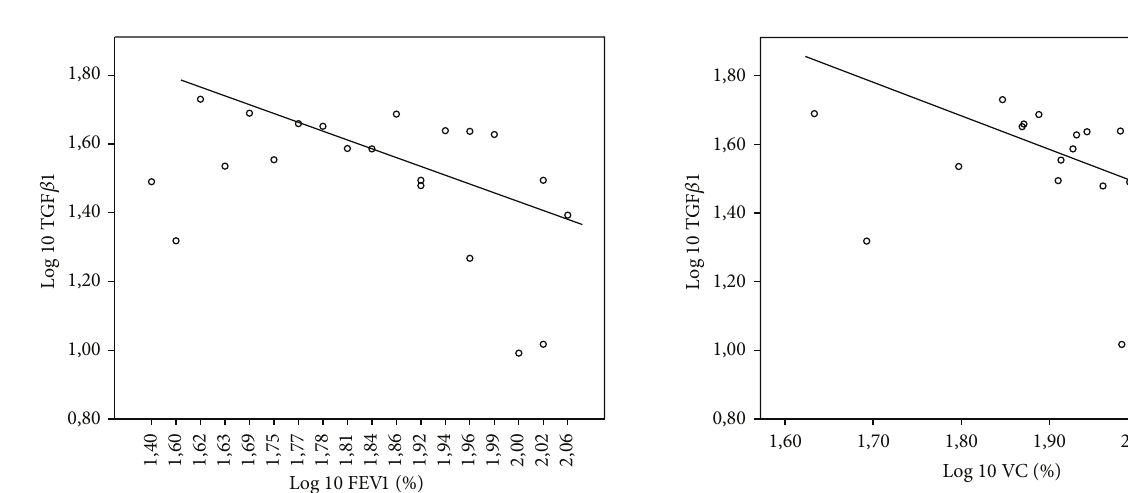
Figure 3: Log 10 TGF 𝛽 1 (pg/mL) in serum in CF patients plotted as a function of Log FEV1 (%) with linear regression line ( 𝑟 = −0.488 , 𝑃 < 0.025 ).